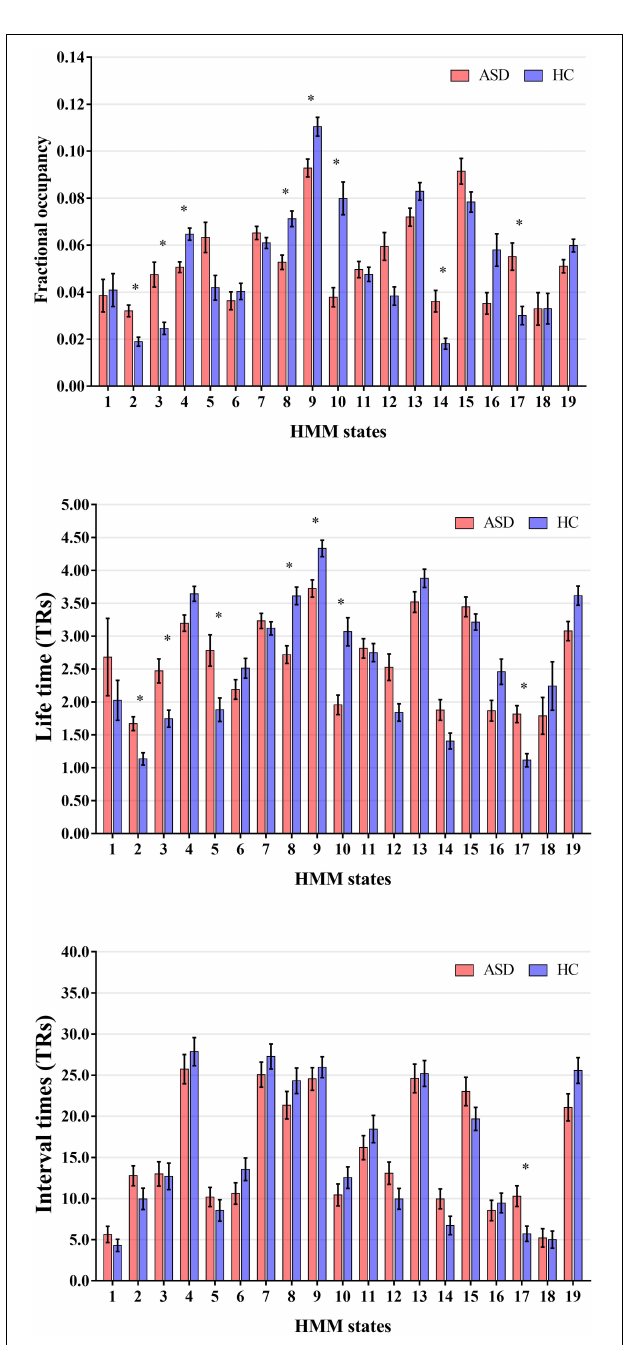
FIGURE 3 | Alteration of the global temporal characterizes in autism spectrum disorder (ASD). *Represented the significant difference between ASD and HC ( p <